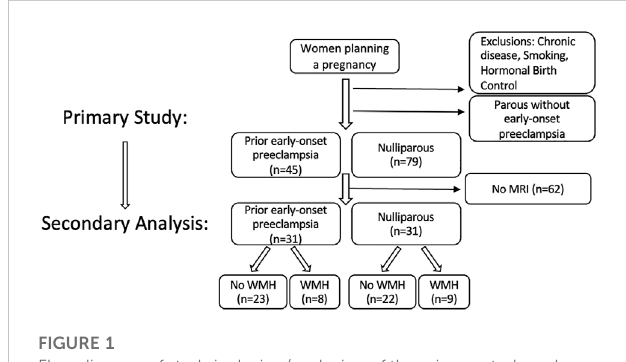
FIGURE 1 Flow diagram of study inclusion/exclusion of the primary study and secondary analysis presented here, to evaluate whether there are cardiovascular associations between the presence/absence of white matter hyperintensities identi fi ed in the brains of healthy reproductive-aged women.